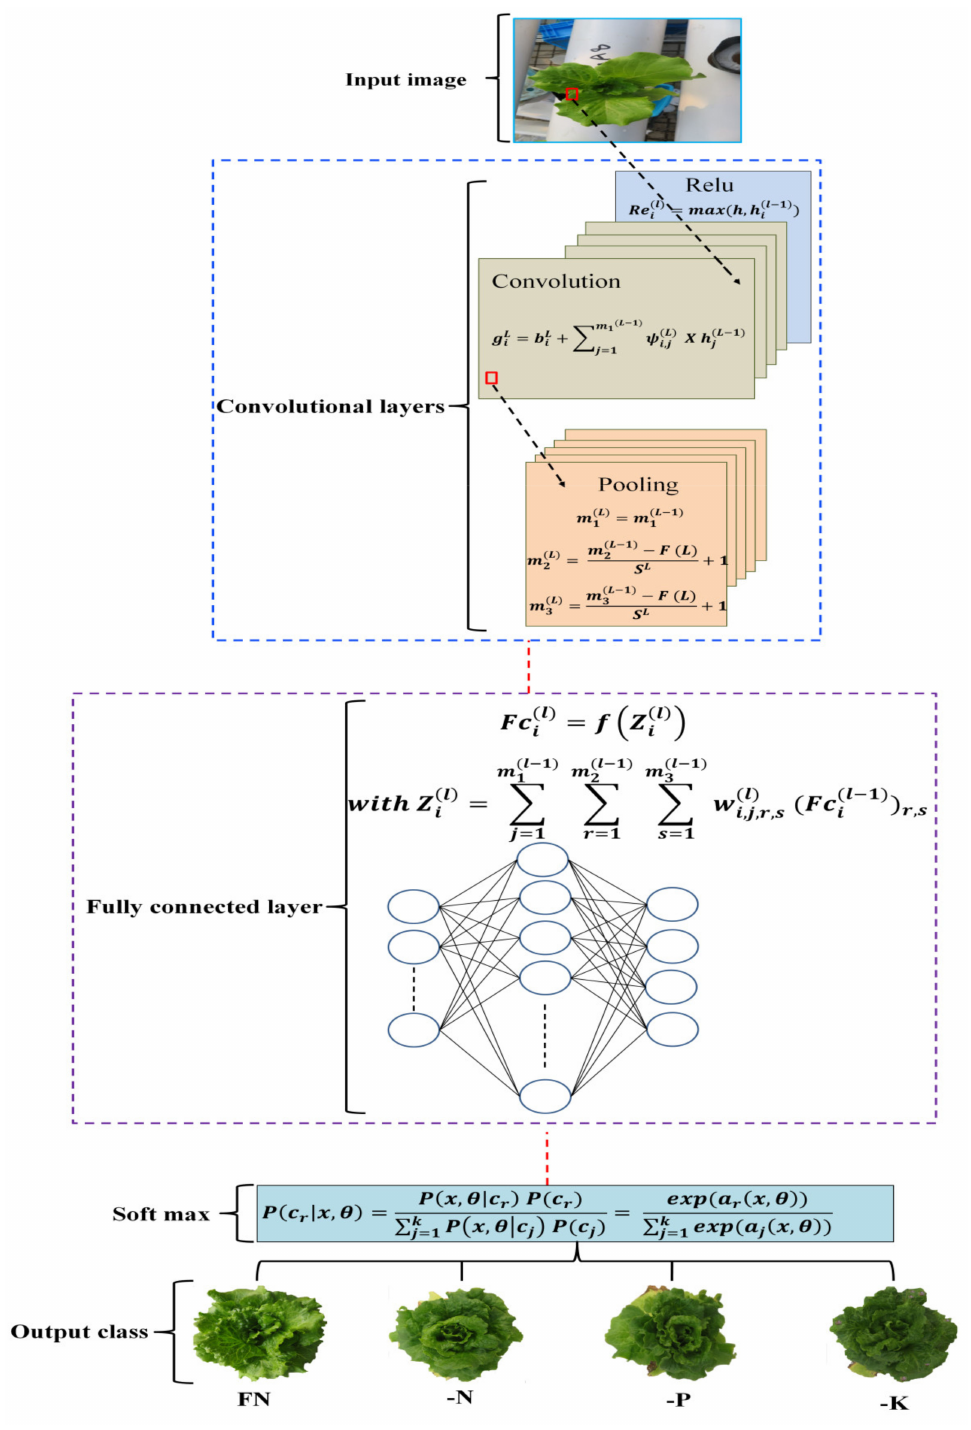
Figure 6. A typical architecture of the Deep Convolution Neural Network (DCNN) consisting of four main